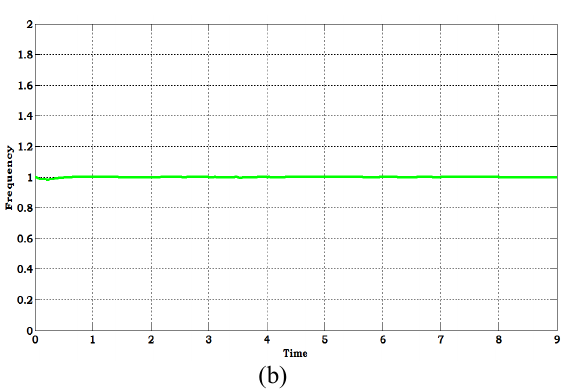
Figure 15. (a). DC link voltage, (b).Frequency (ii). Artificial Neural Network (ANN) Based System Test Case 1: When operating system in grid connected mode with battery